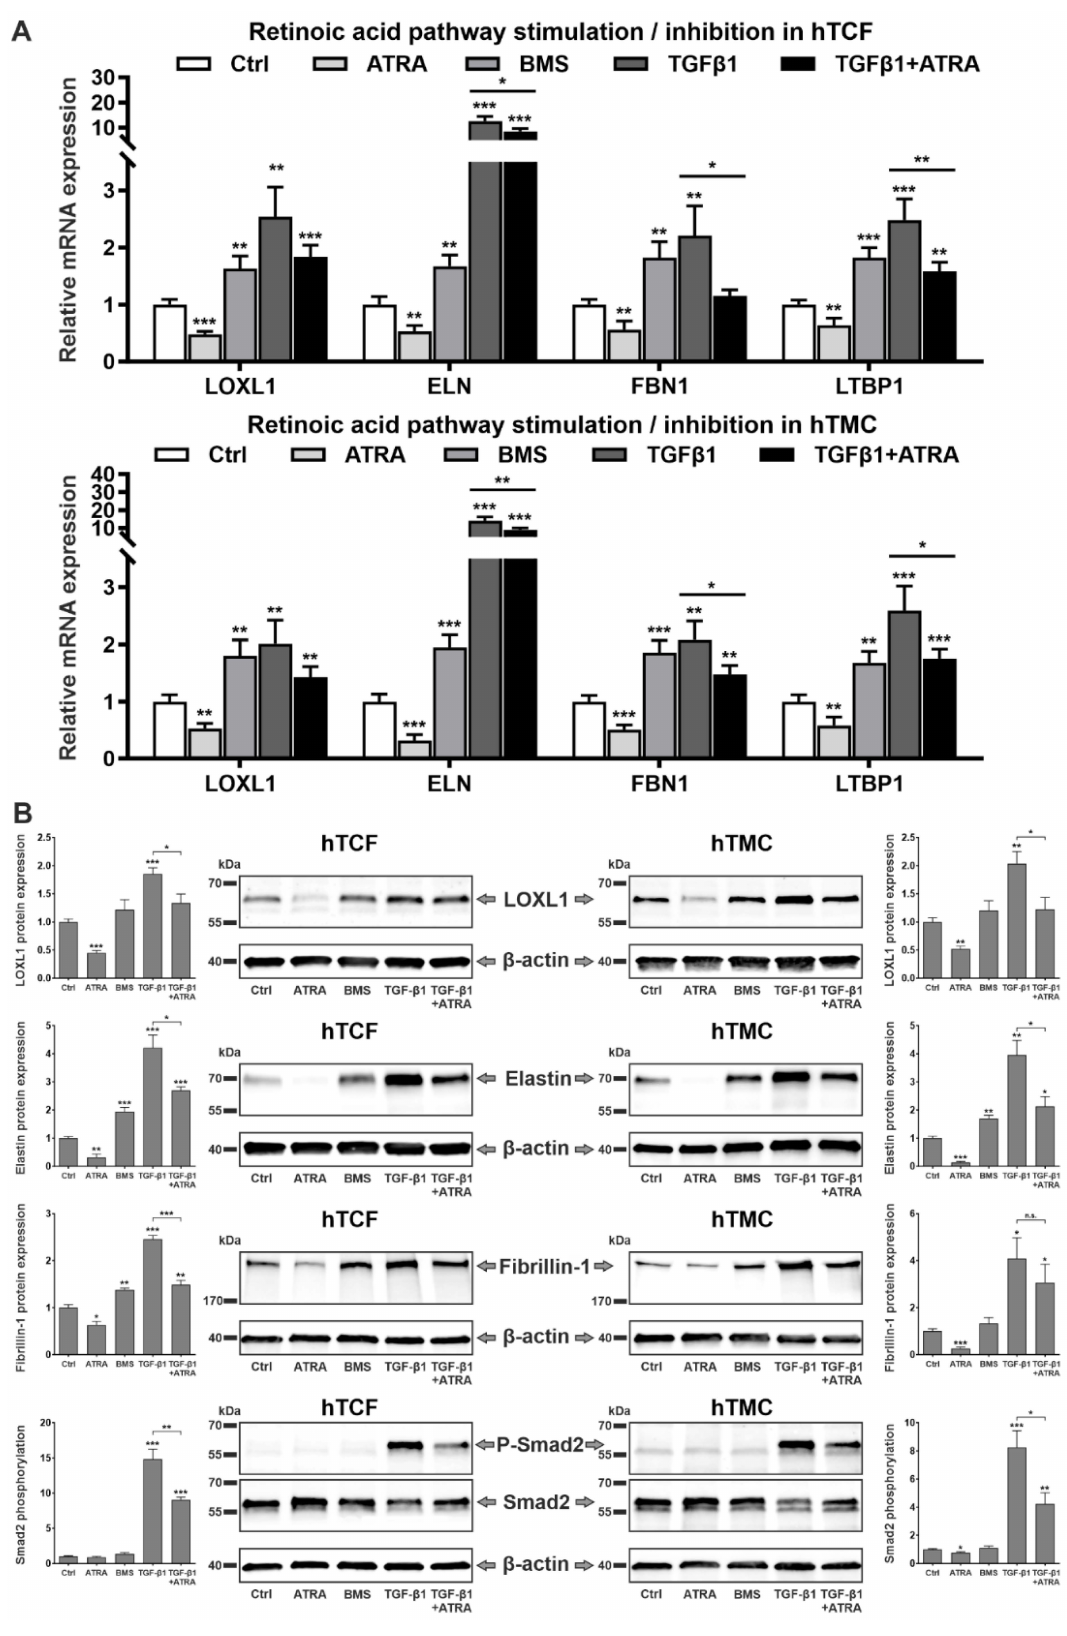
Figure 8. Effects of retinoic acid signaling activation and inhibition on TGF- β 1-induced matrix synthesis in PEX-relevant cell types. ( A ) Quantitative real-time PCR analysis of LOXL1 (lysyl oxidase-like 1),